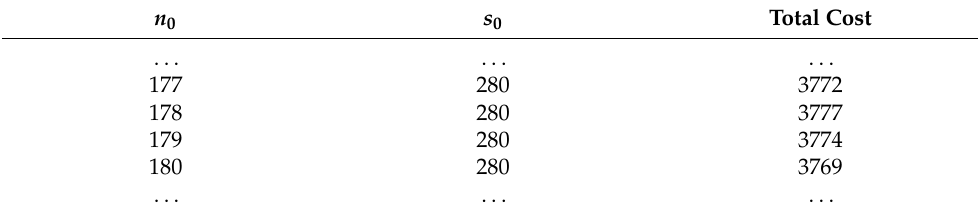
Table 4. Results of the pre-test of the threshold values.